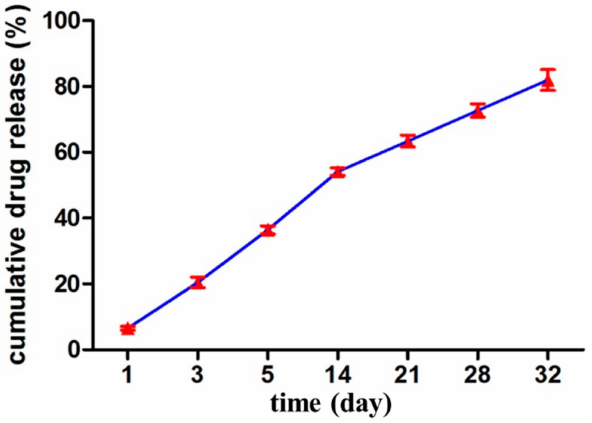
Figure 7. Release of VCM from TMC nanoparticles in PBS (pH 7.4) at 37 ˝